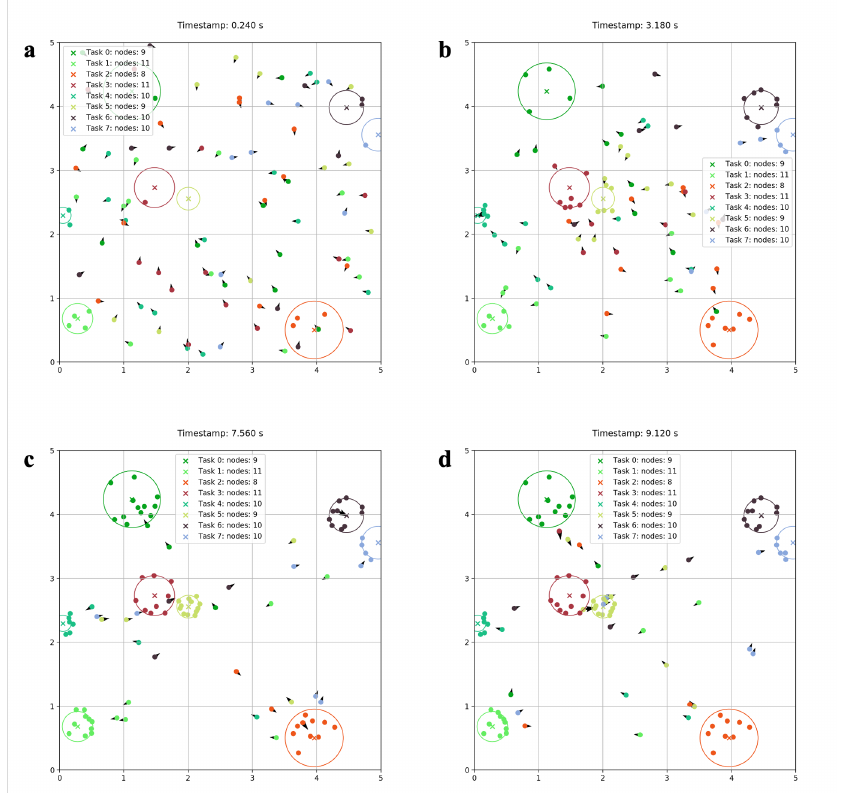
Figure 4. Illustration of a procession in time ( a – d ) of a simulation with 8 randomly placed tasks, with random radii, in a 5 × 5 unit field, where 100 nodes are placed at time 0 at random locations. In the legend “Task 0: nodes: 9” represents a task with ID 0 and expected 9 nodes to